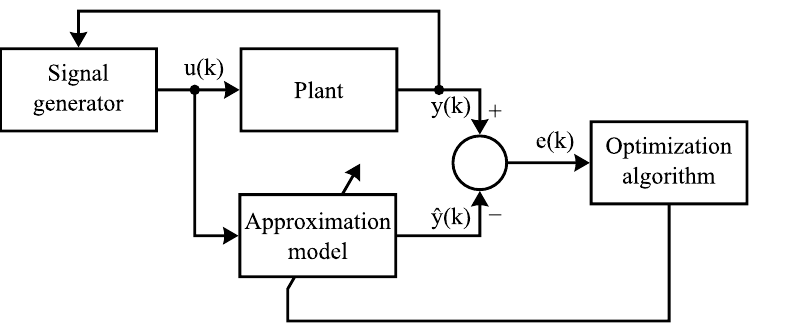
Figure 7. General schema for experimental parameter identification driven by output prediction error.